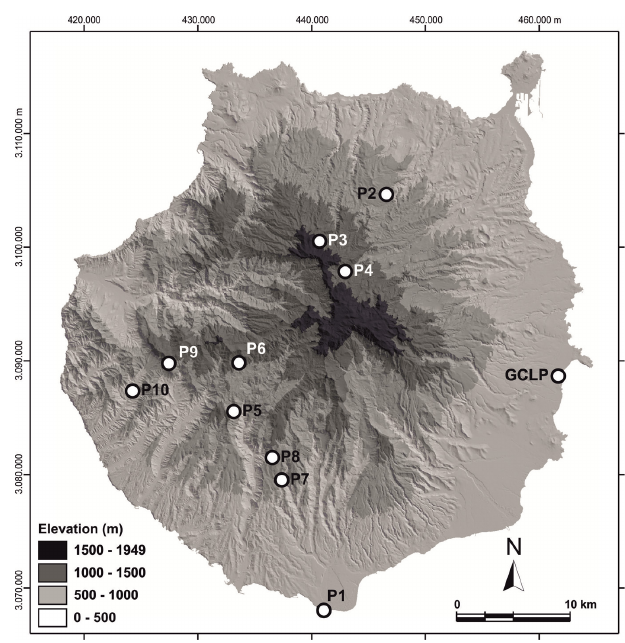
Fig. 2. Topographic map and geographic location of measurement stations in Gran